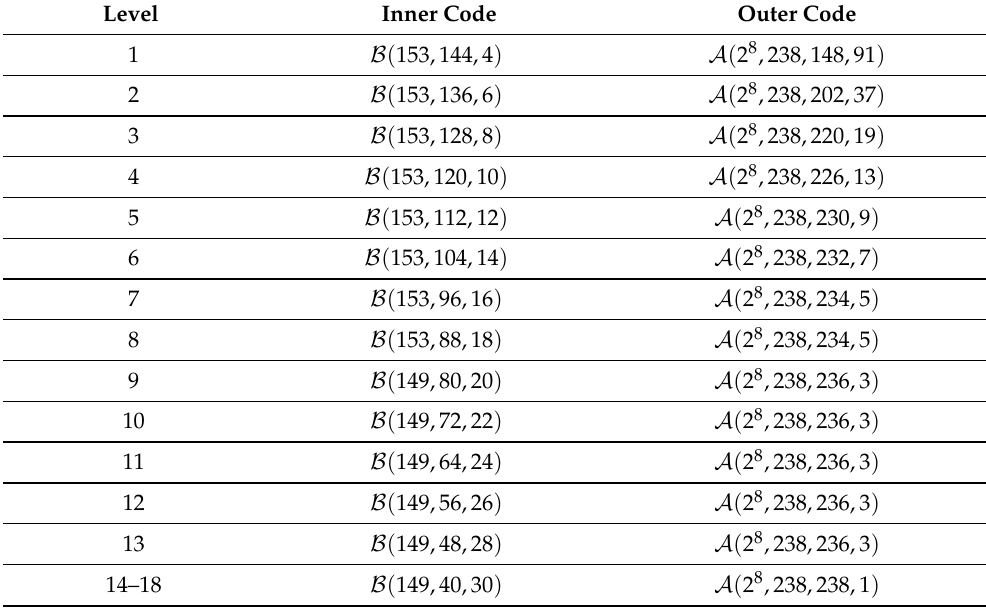
Table 3. Exemplary GC code ( N = 36,414, K = 32,768, R ≈ 0.9) for TLC (designed for WER 10 − 15 ).